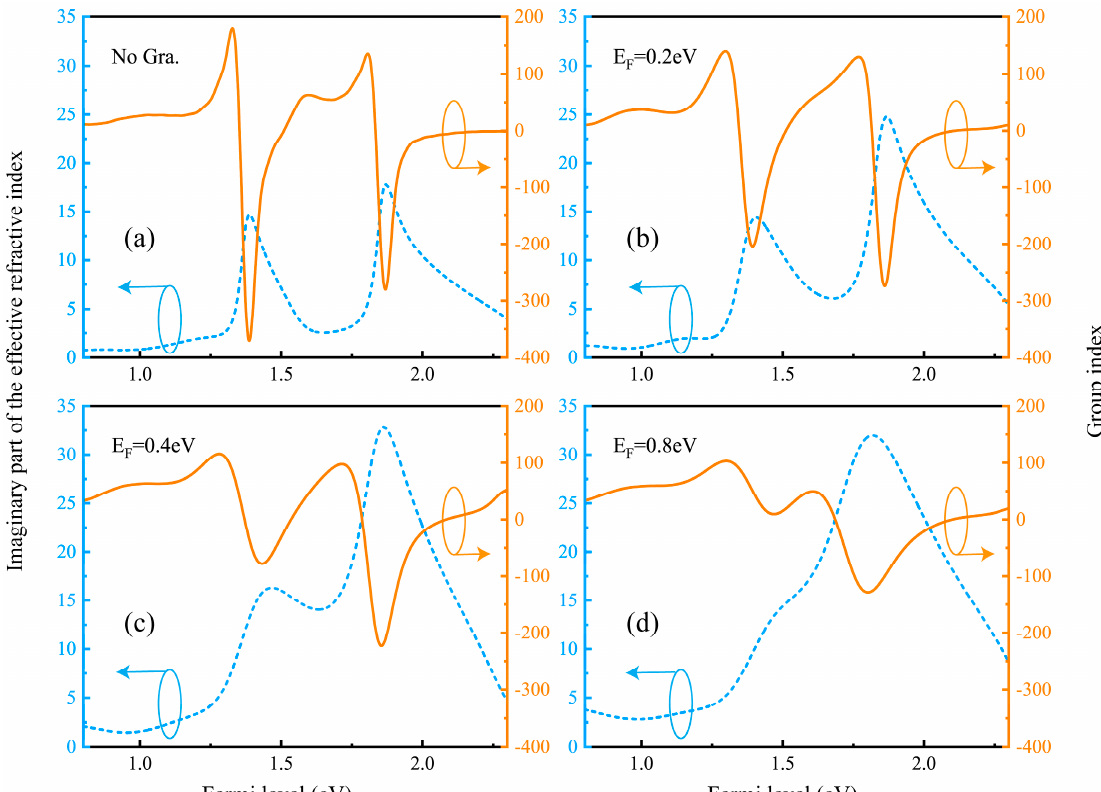
Figure 6. ( a – d ) The group index n g and the imaginary part of the effective refractive index Im (n e ) for the proposed hybrid metal-graphene metamaterials with various Fermi level E F of graphene.